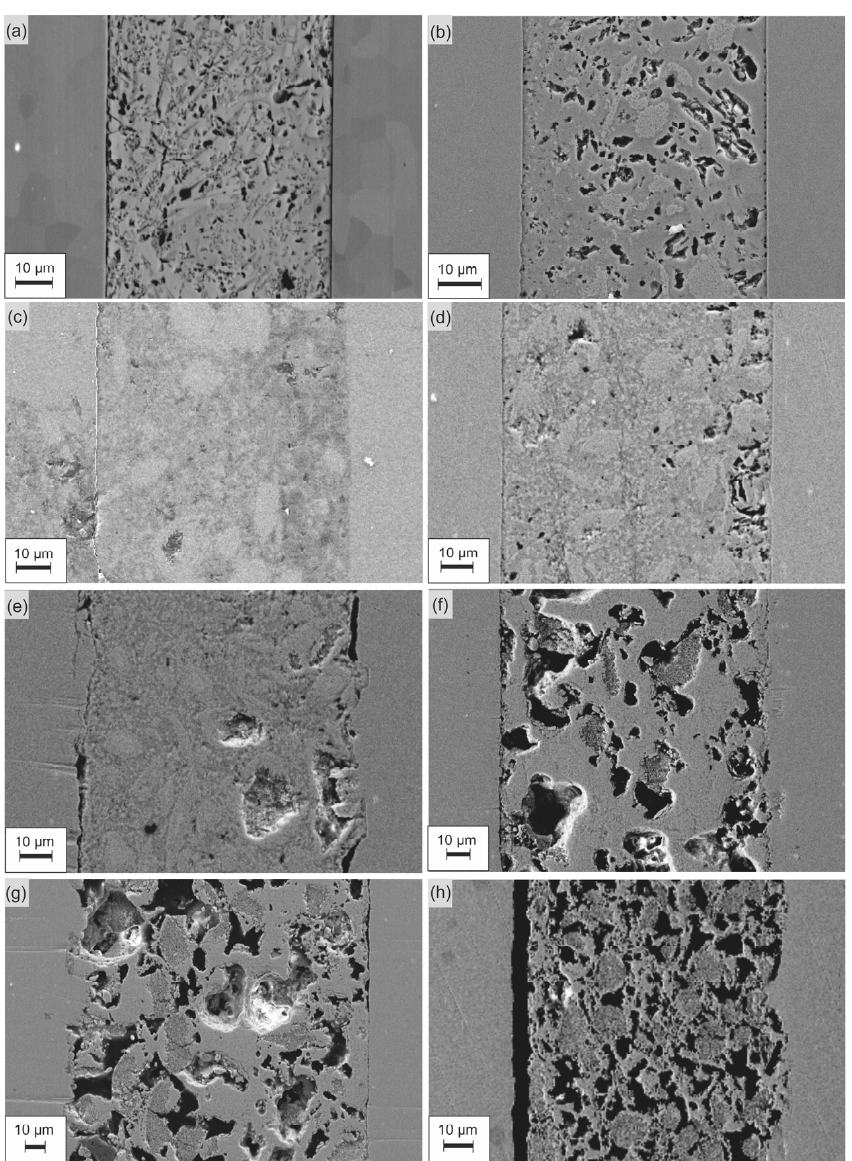
Figure 4. Cross-sections of the obtained samples consisting of 0–70 wt.% YSZ: ( a ) reference glass sample, ( b ) composite with 10 wt.% YSZ, ( c ) composite with 20 wt.% YSZ, ( d ) composite with 30 wt.% YSZ, ( e ) composite with 40 wt.% YSZ, ( f ) composite with 50 wt.% YSZ, ( g ) composite with 60 wt.% YSZ, and ( h ) composite with 70 wt.% YSZ.